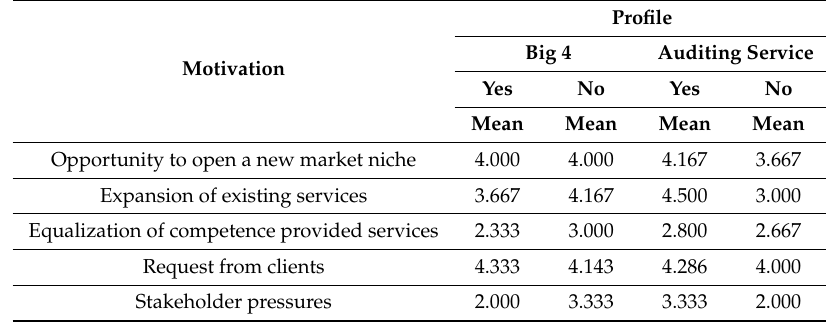
Table 8. Motivation for offering the